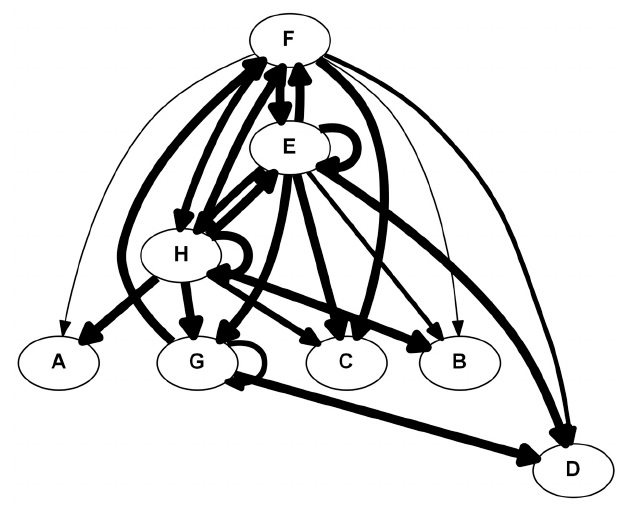
Figure 4. DyBN using example data: The DyBN algorithm was performed on the example dataset, including data from all times, resulting in a single network representing the entire time course. This network features variables with higher levels (E, F, G, H) in central roles.